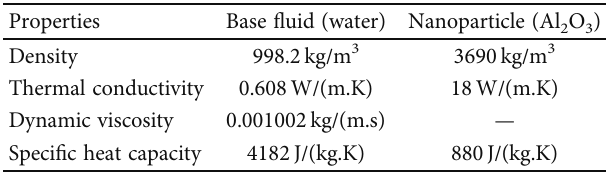
Table 2: Properties of Al